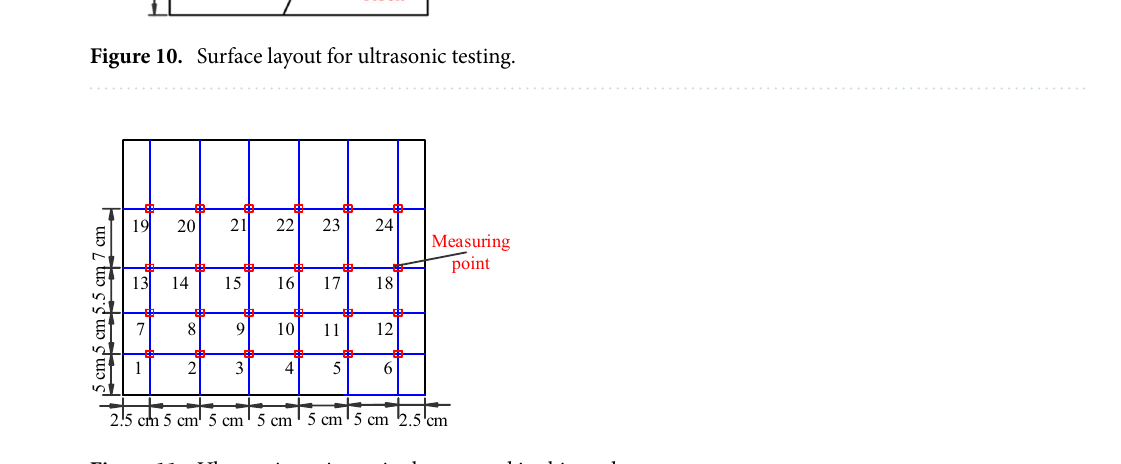
Figure 11. Ultrasonic testing point layout used in this